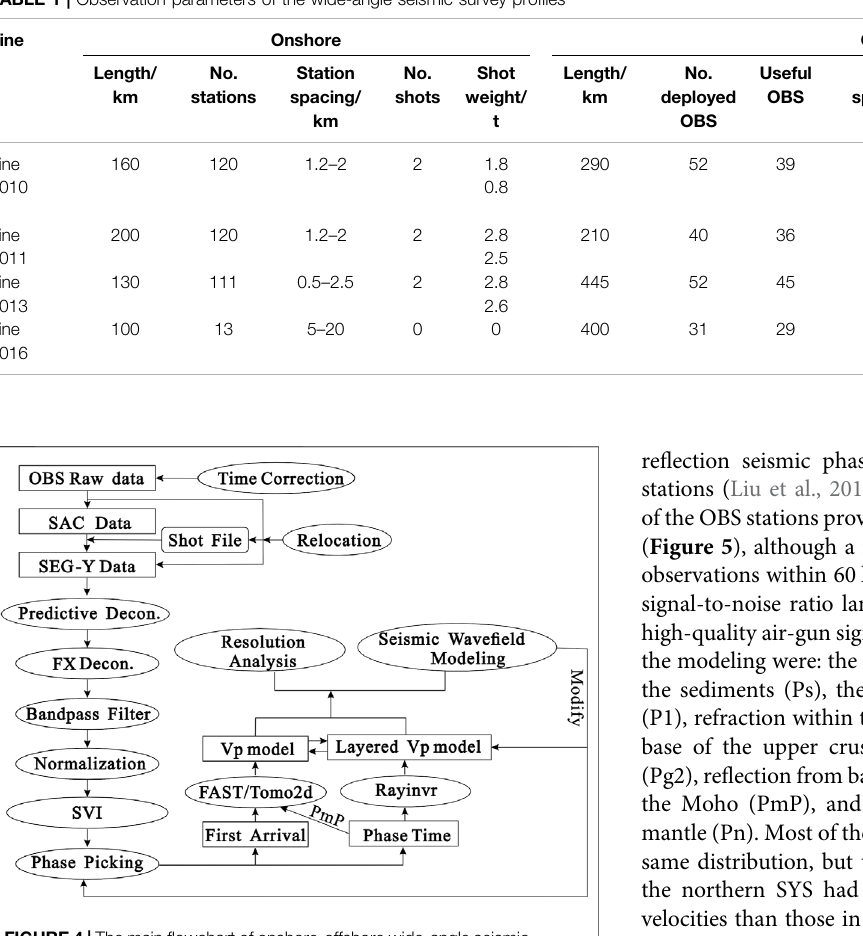
FIGURE 4 | The main fl owchart of onshore-offshore wide-angle seismic data processing. The abbreviations include Decon.: Deconvolution, SVI, Super Virtual Interferometry. FAST, Tomo2d and Rayinvr are three different modeling software packages developed by Zelt and Barton (1998), Korenaga et al. (2000), and Zelt and Smith (1992),